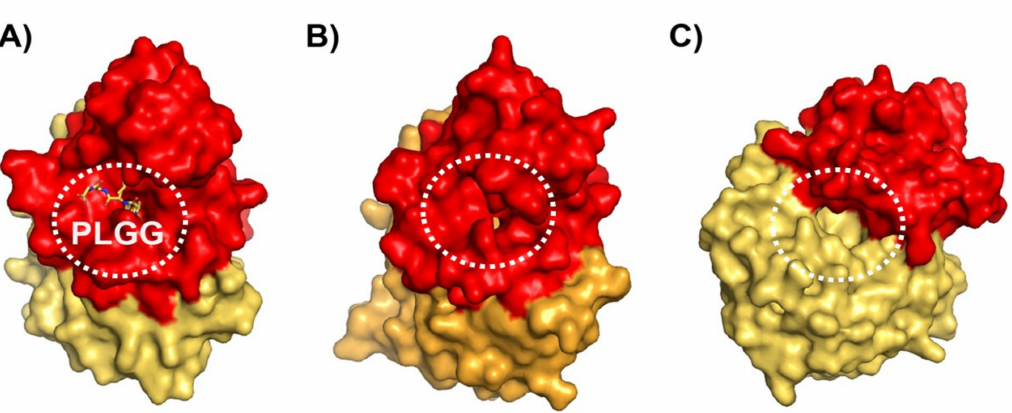
Figure 5. ( A ) Surface representation of APF1 showing the binding site of the tetrapeptide PLGG (E213Q mutant, PDB 1XRP). Red: Cap domain; orange: Catalytic domain. ( B ) Surface representation of PsyPAH showing the putative substrate binding site. Red: Cap domain; orange: Catalytic domain. The orientation is exactly the same as in ( A ). ( C ) Surface representation of XcPAP showing the putative substrate binding site. Red: Cap domain; orange: Catalytic domain. The orientation has been rotated approximately 90 ◦ with respect to ( A